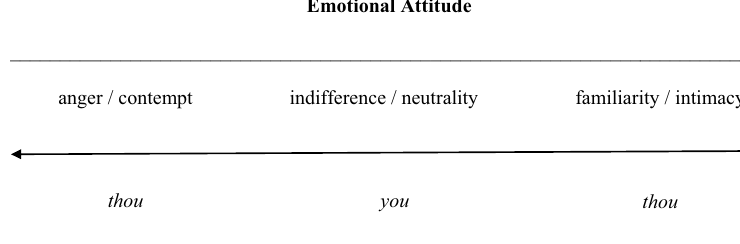
Figure 2: The axis of emotional